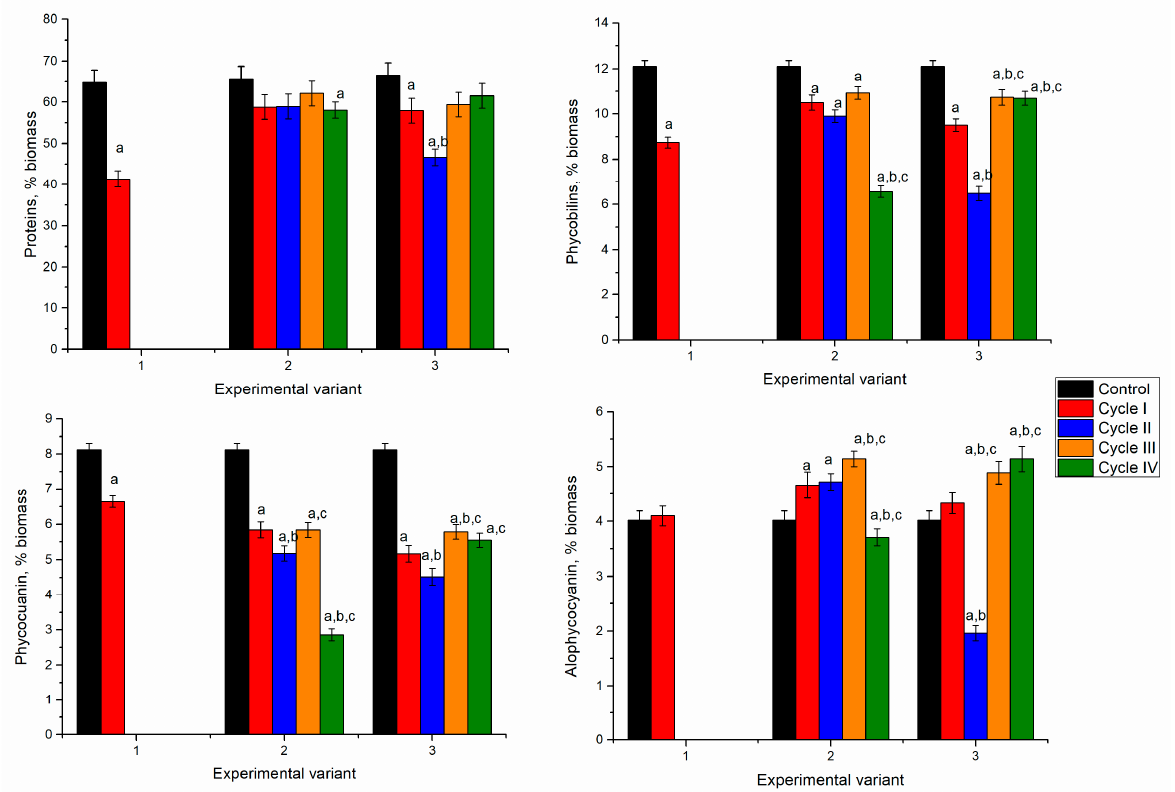
Figure 12. The content of proteins and phycobiliproteins in spirulina during repeated cultivation in the medium containing metal ions at concentrations: nickel 2.5–10 mg/L, copper 1–5 mg/L, zinc 0.5–2 mg/L, and molybdenum 0.5 mg/L. a: p < 0.001 for the difference between experimental and control samples; b: p < 0.001 for the difference from the first cycle; c: p < 0.001 for the difference from the second cycle.